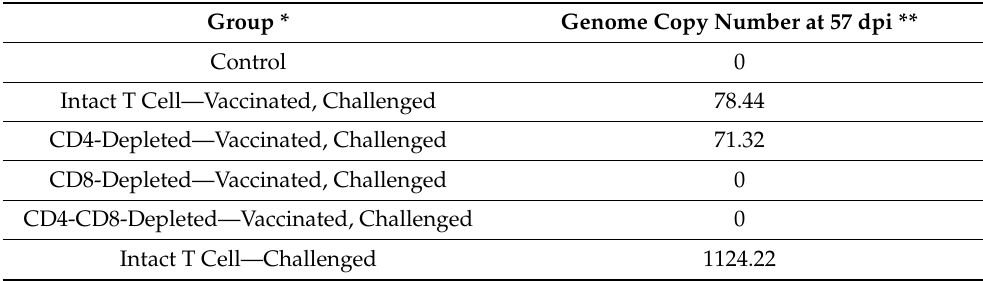
* 3 samples/virus group tested in triplicates; ** (MDV genome copy number/GAPDH copy number) ×